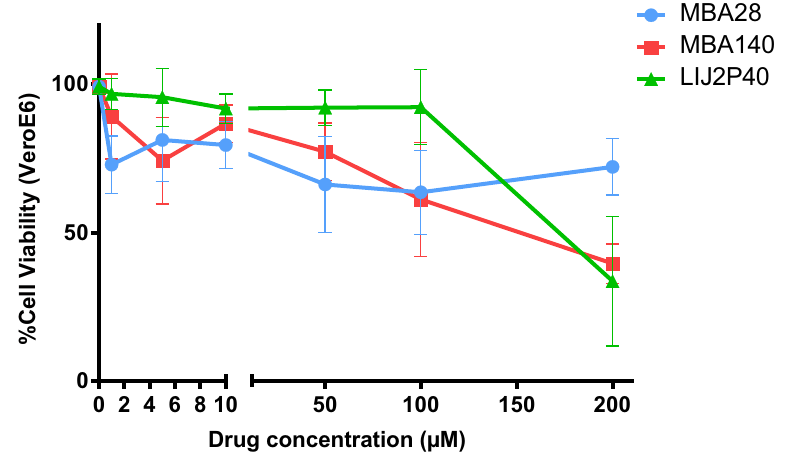
Figure 3. Viability of Vero E6 cells treated with MBA28, MBA140 or LIJ2P40 drugs measured by WST-1 assay. WST-1 viability assays were performed after 48 h. Untreated cells were used for normalization of the WST-1 viability assay. Results are represented as mean ± SD of three biological replicates.